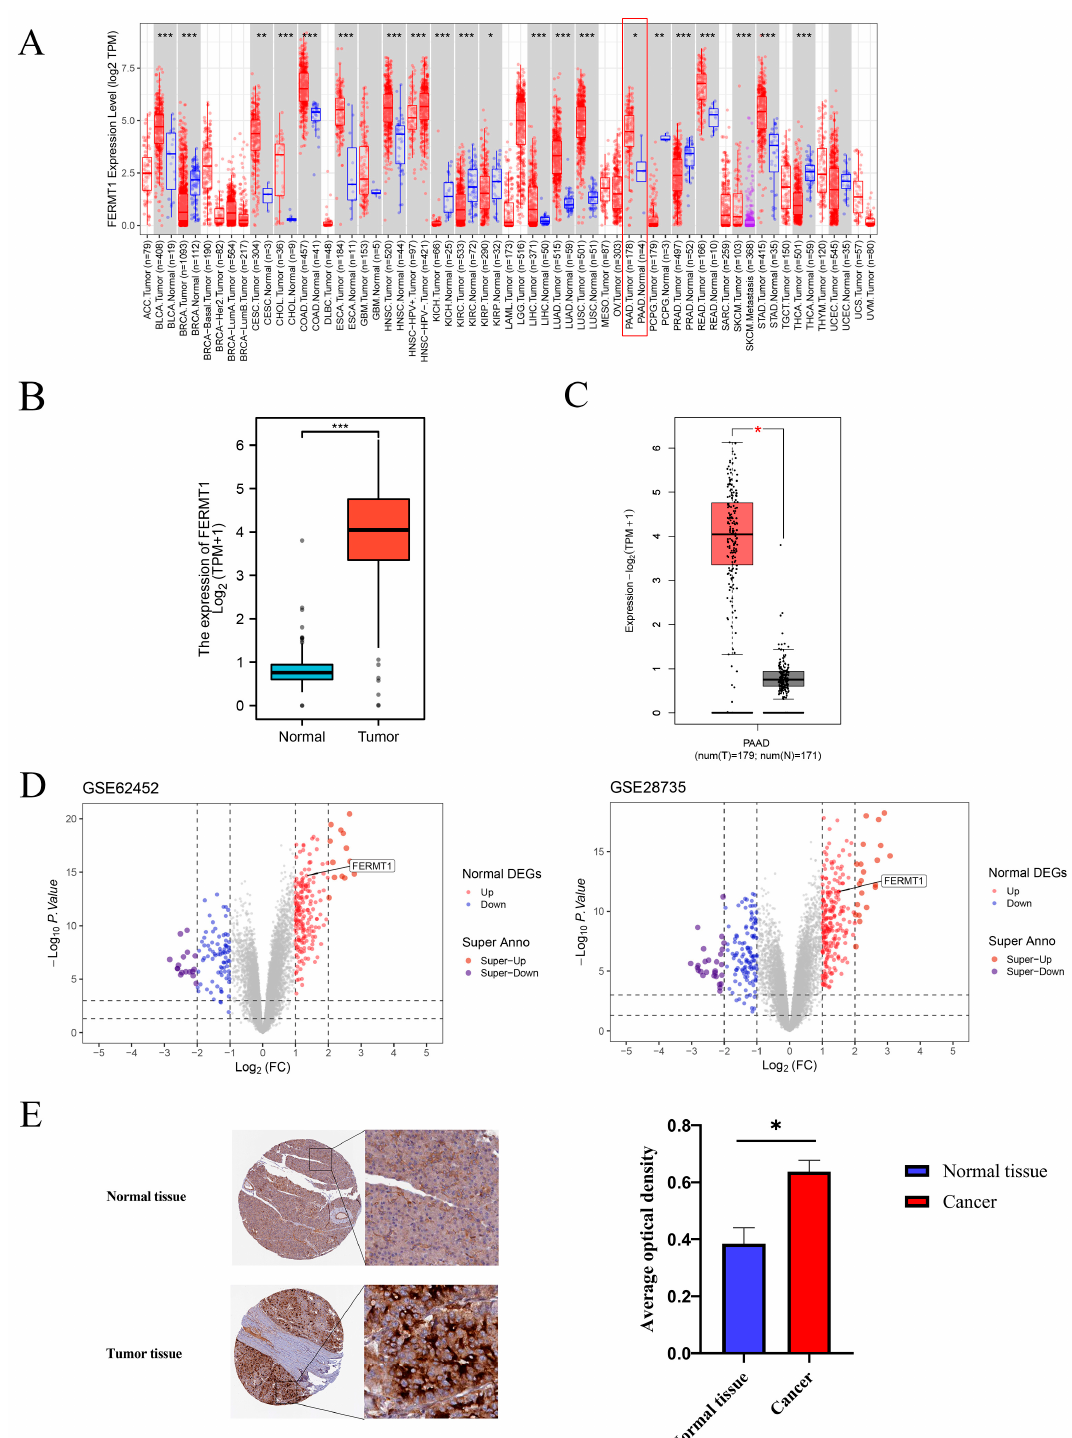
Figure 1. The expression of FERMT1 in pan-cancer and PAAD. ( A ) FEMRT1 expression in different cancers based on TIMER database. ( B ) FERMT1 expression levels in PAAD and corresponding normal tissues in TCGA-PAAD, ( C ) GEPIA 2 and ( D ) GEO datasets (GSE62452 and GSE28735). ( E ) FERMT1 protein level in PAAD and adjacent normal tissues determined according to the HPA database. * p < 0.05, ** p < 0.01, *** p < 0.001.